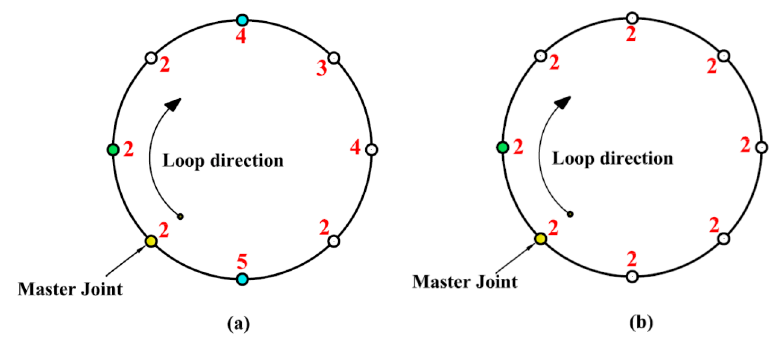
Figure 7. Schematic diagram for a given loop ( a ) has multiple consequent master joints. ( b ) has unified master joint degrees.